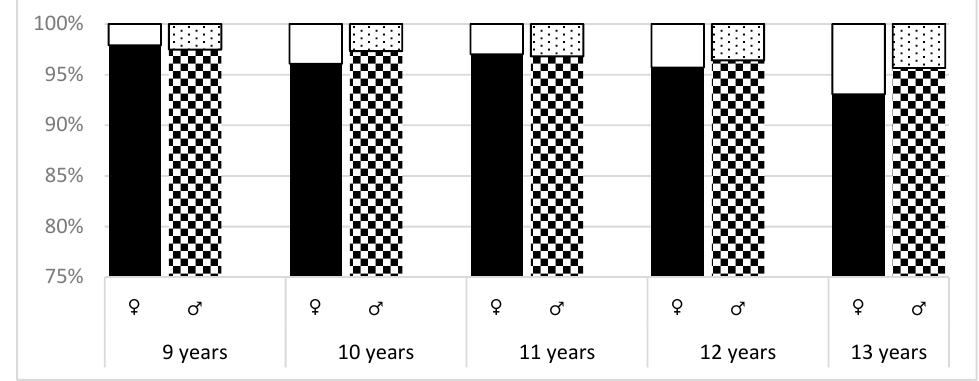
Figure 1. ATR absolute values—comparison of differences between age and sex (level 1). * * In the upper part of the bar are presented children whose ATR is more than 3º, in the lower part ATR = 0º– 3º (Figure 1,2,3).